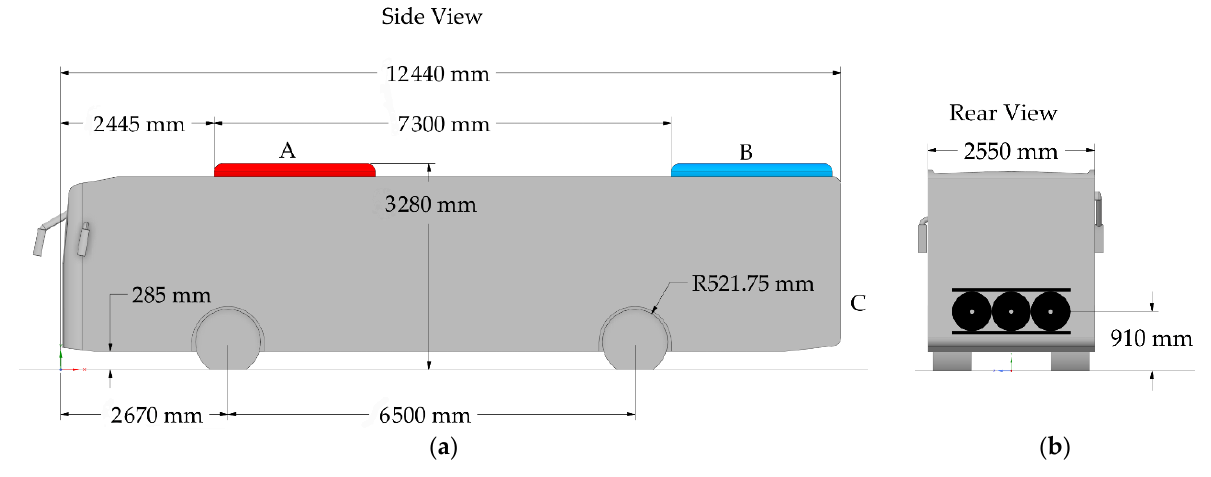
Figure 1. Schematic of the bus ( a ) side and ( b ) rear view.